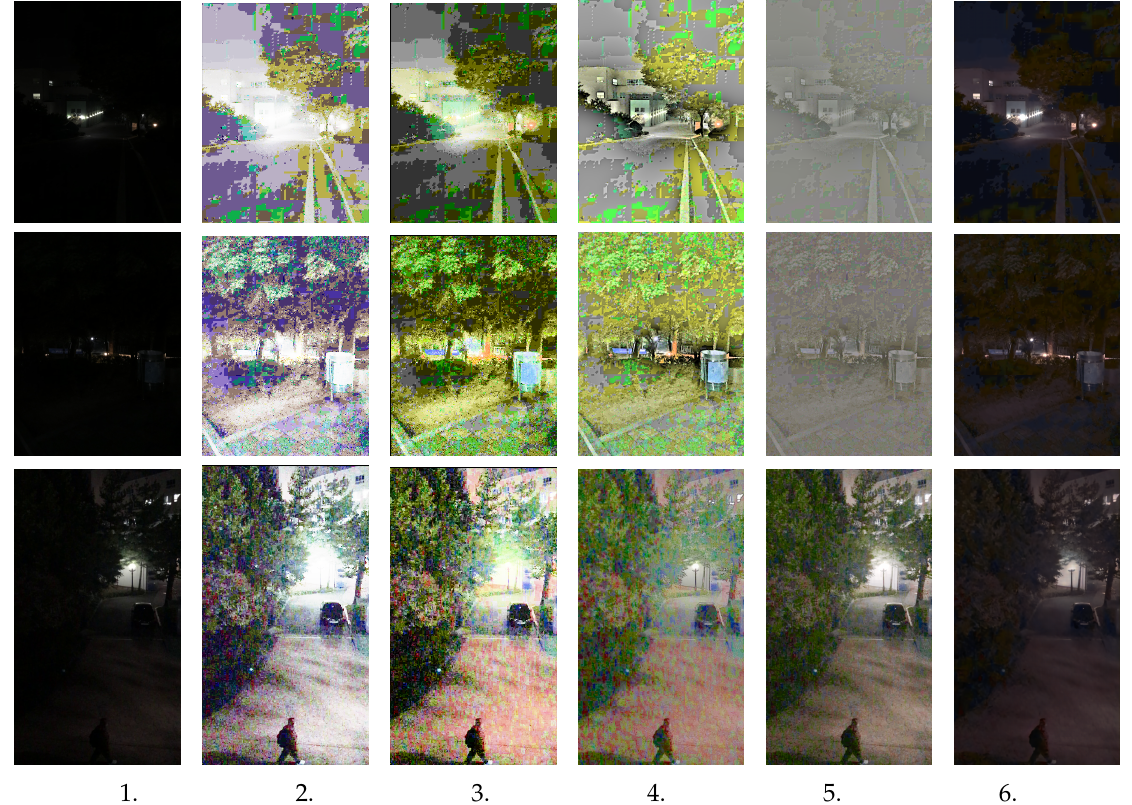
Figure 4. The testing results with an extreme low-light outdoor image from first (left) to last (right): 1. input image, 2. HE [25], 3. DHE [26], 4. Retinex [28], 5. GLADNet [31], and 6. Our proposed